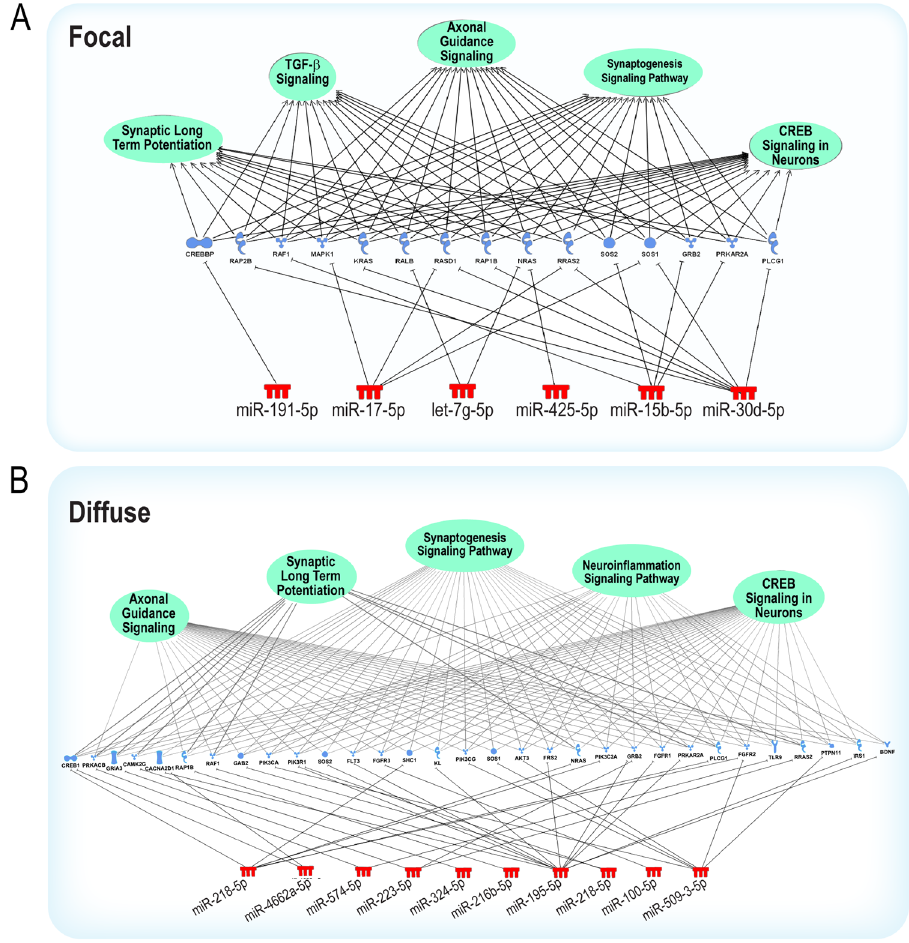
Figure 4. Pathway analysis reveals predicted gene targets enriched in predominately nervous system signaling pathways for focal ( A ) or diffuse ( B ) injury cohorts. miRNA colors signify increased (red) expression compared to control samples. The color of the gene targets represents the predicted direction of regulation based on target-prediction using miRDB. The green circles represent biological pathways comprising of predicted genes based on Ingenuity Pathway Analysis. Data were analyzed through the use of IPA (QIAGEN Inc., https://www.